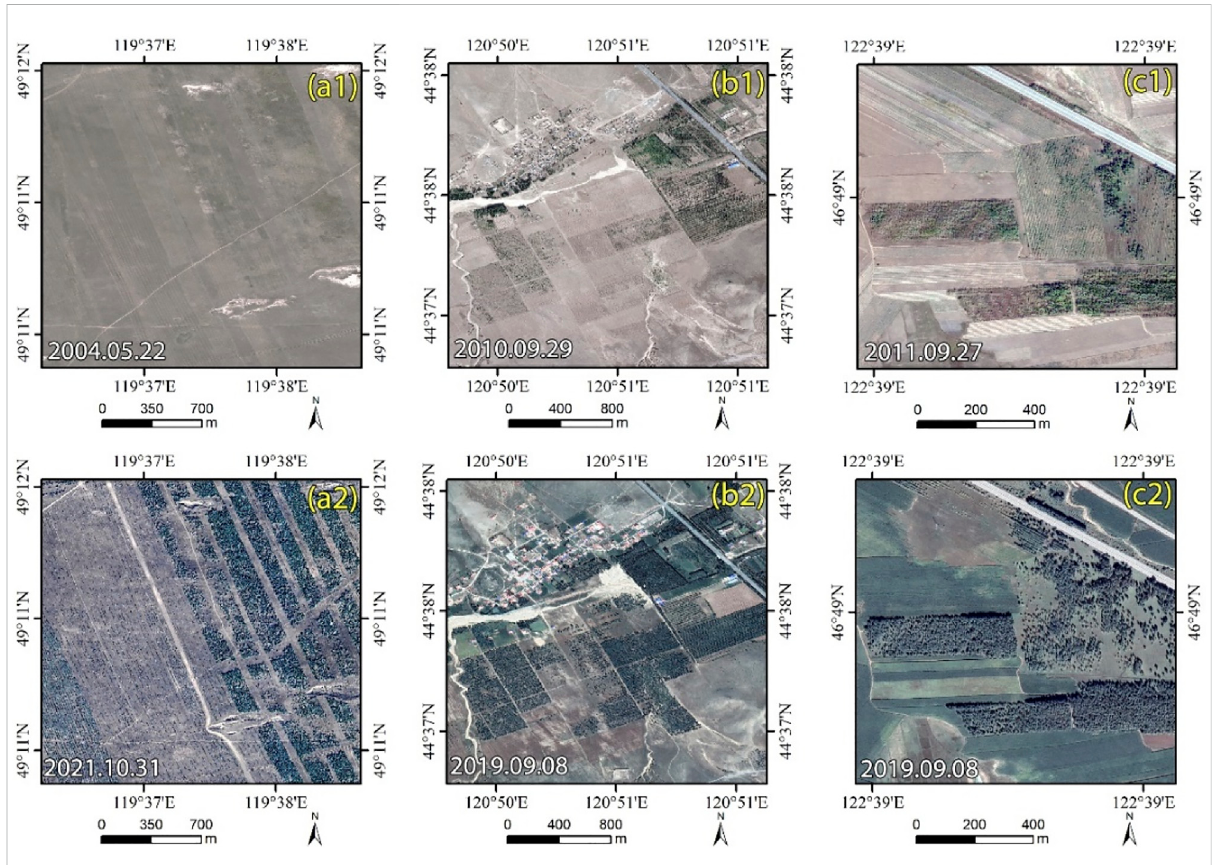
FIGURE 4 Comparison of vegetation cover by implementing afforestation measures (a1 and a2 are farmland, b1, b2, c1, and c2 are